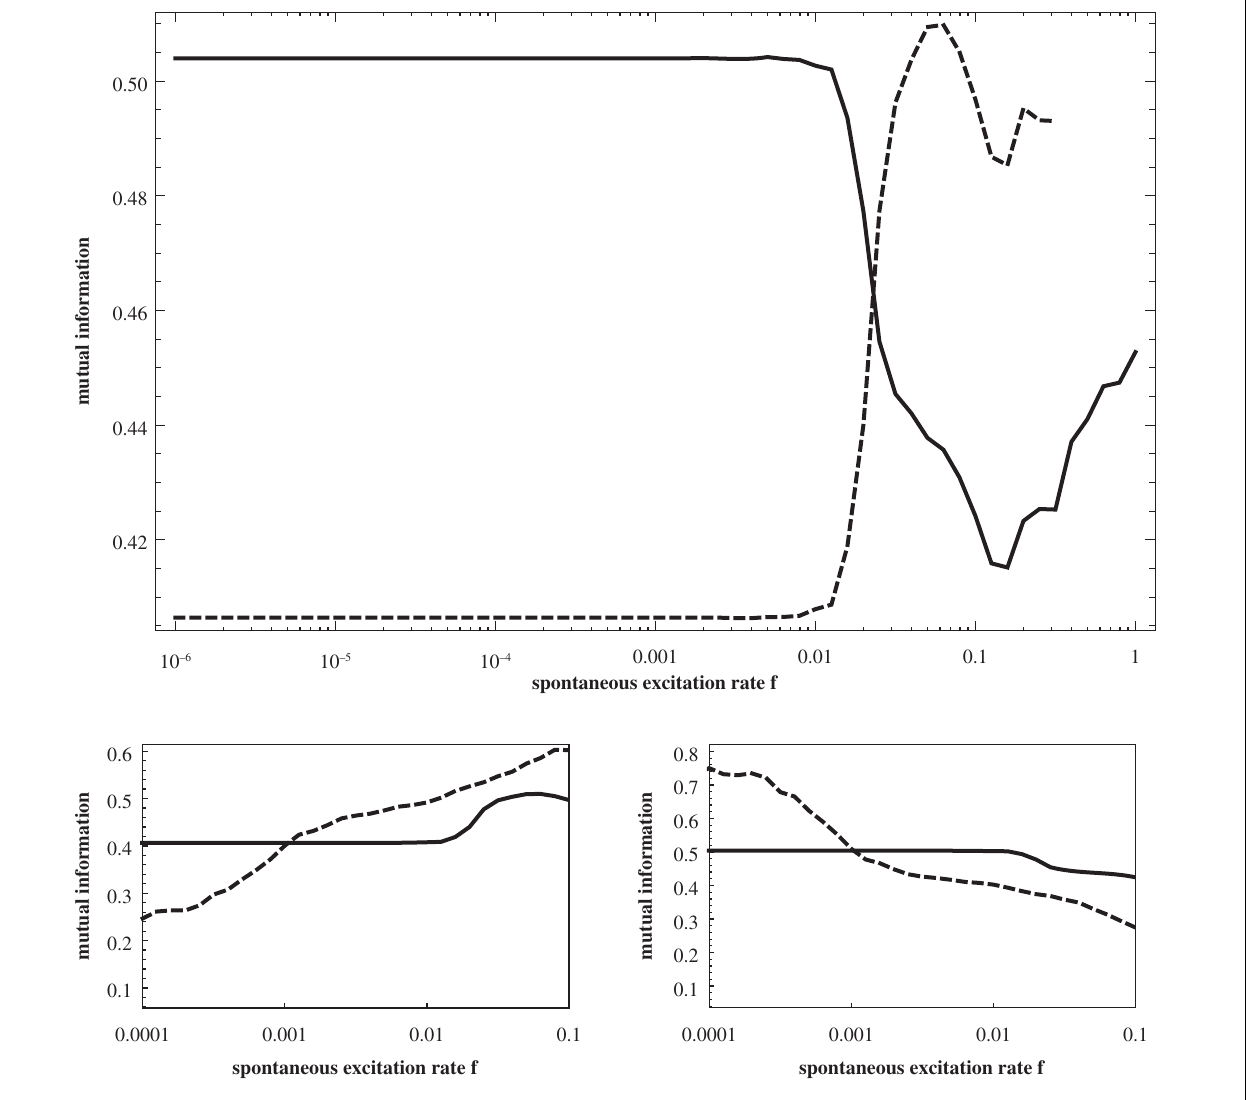
FIGURE 8 | Upper fi gure: Mutual information as a function of f , measuring the correlation of the predicted similarity matrix Q (matrix T ; dashed curve) and with distance to the central node (matrix D ; full curve). Compared to Figure 7 ( N = 64) the graph size is now N = 256. The lower two fi gures compare each of these curves (left-hand side: modularity; right-hand side: central node; full curve: prediction; dashed curve: result from numerical